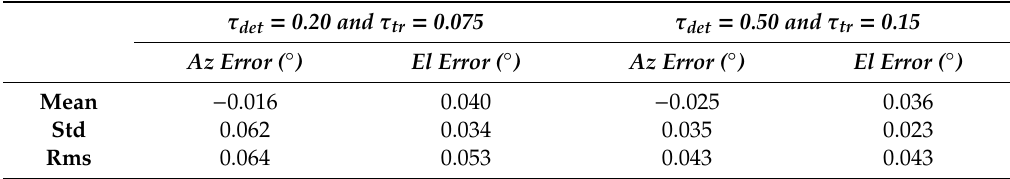
Table 9. Statistical analysis of the accuracy in the estimated target LOS. DL-based detector and tracker applied on the images (1330) from FT1-B.